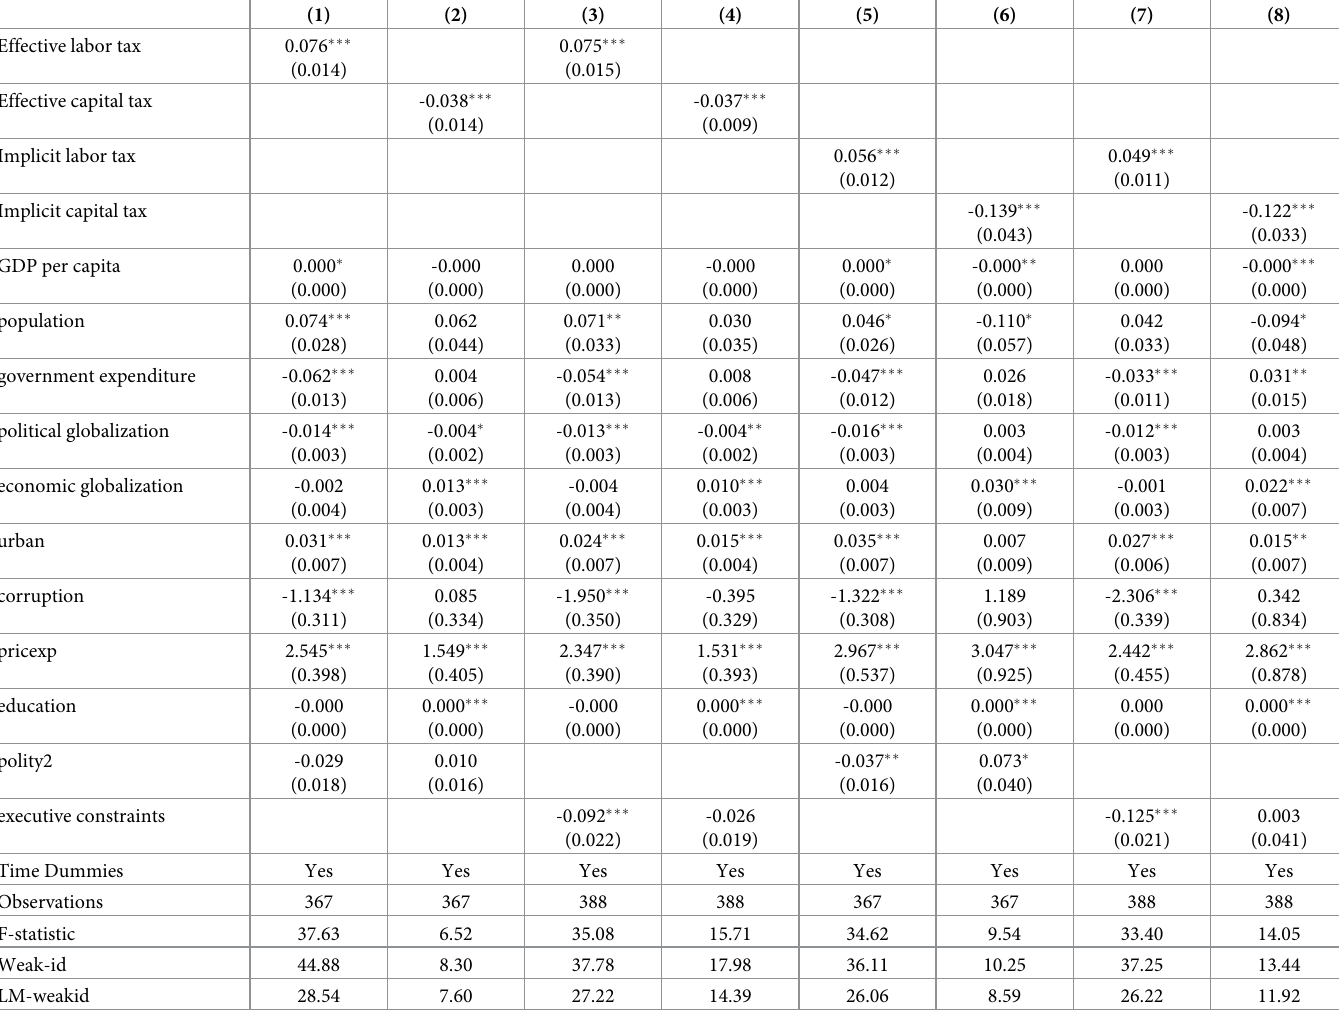
Table 9. The impact of taxation on economic sophistication: Alternative institutional